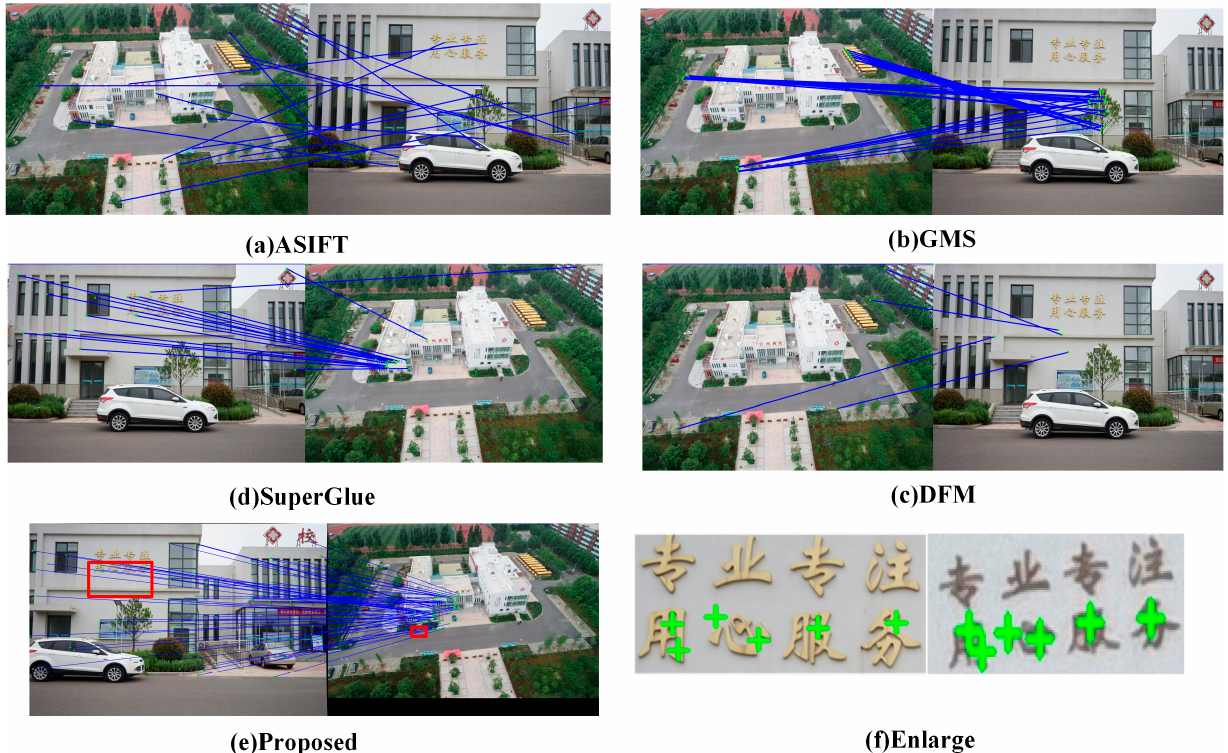
Figure 15. Image feature-matching comparison on the hospital image in the Shandong University